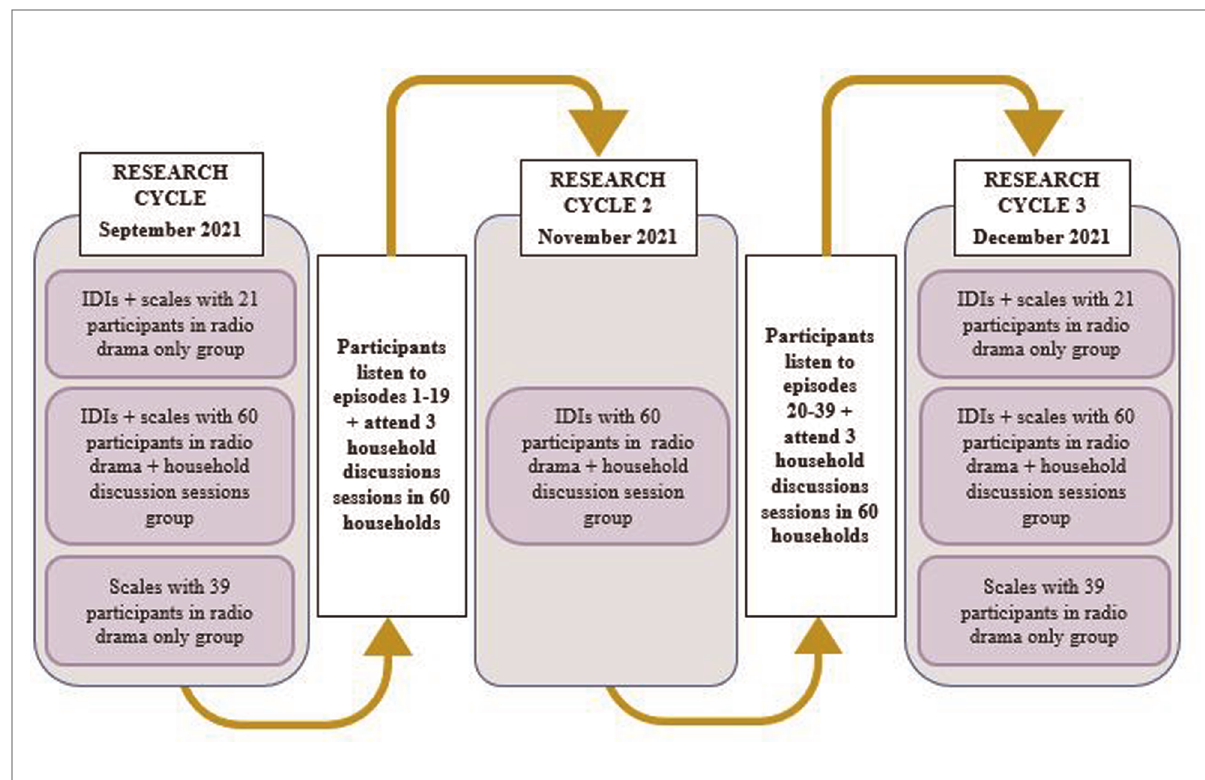
FIGURE 1 Diagram depicting data collection cycles of in-depth interviews (IDIs) and questions from the Norms and Attitudes on Age Disparate Transactional Sex scale (NAATSS) and the Gender Roles and Male Provision Expectations (GRMPE)